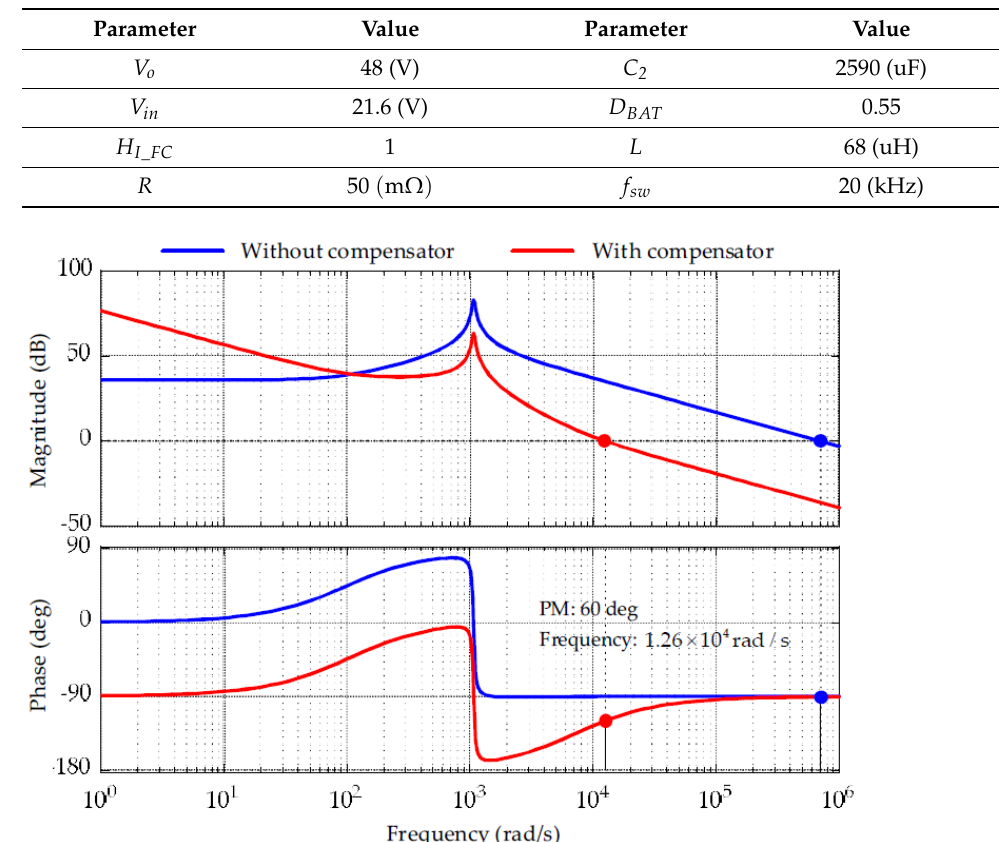
Figure 13. Bode diagram of the BAT current control loop.